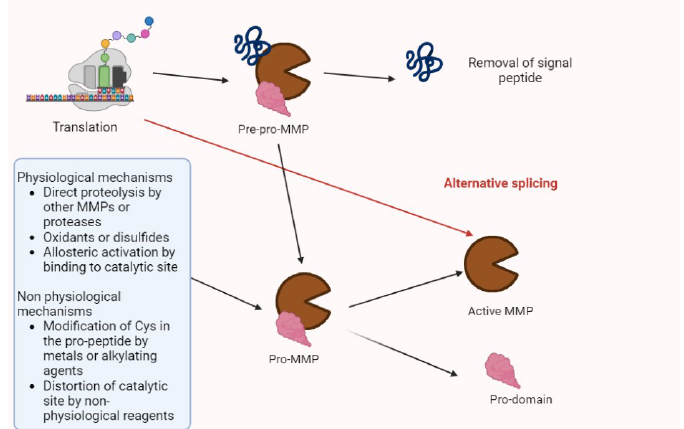
Figure 1. The activation of MMPs. After translation, MMPs are in the pre-pro-enzyme form, consti- tuted by a signal peptide, a pro-domain, and enzyme complex. After the removal of signal peptides, the residual pro-MMP may be activated by several factors summarized in the figure. Then, the pro- domain undergoes proteolysis, and the active isoform may perform its biologic or pathologic func- tions. Alternative splicing may directly generate activated forms.